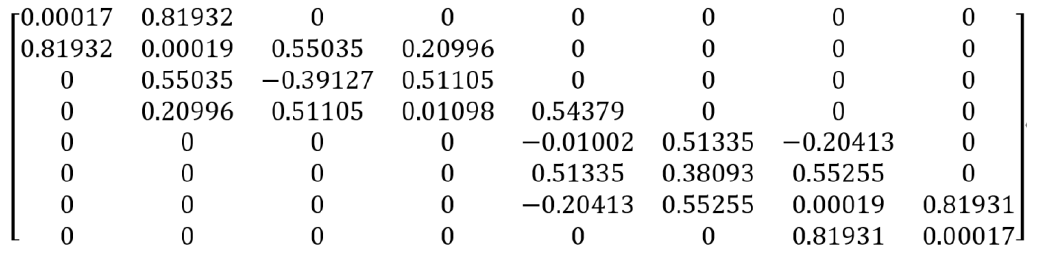
Figure 4. Coupling matrix of 2080 MHz bandpass filter.